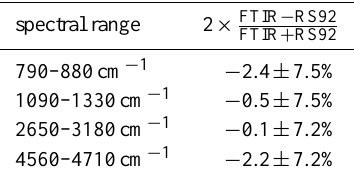
Fig. 14. Difference between the H 2 O profiles retrieved in different spectral regions. Left panel: difference between 790–880 and 2650–3180cm − 1 region; Central panel: difference between 1090–1330 and 2650–3180cm − 1 region; Right panel: difference between 4560–4710 and 2650–3180cm − 1 region. Black line and error bars mean: 1 σ standard deviation of the differences between the 325 retrievals; Grey area: Theoretical differences due to different averaging kernels; see Eq. (2). Table 7. Difference (mean and standard deviation) between coin- cident FTIR and RS92 H 2 O column abundances for the retrievals in the four spectral